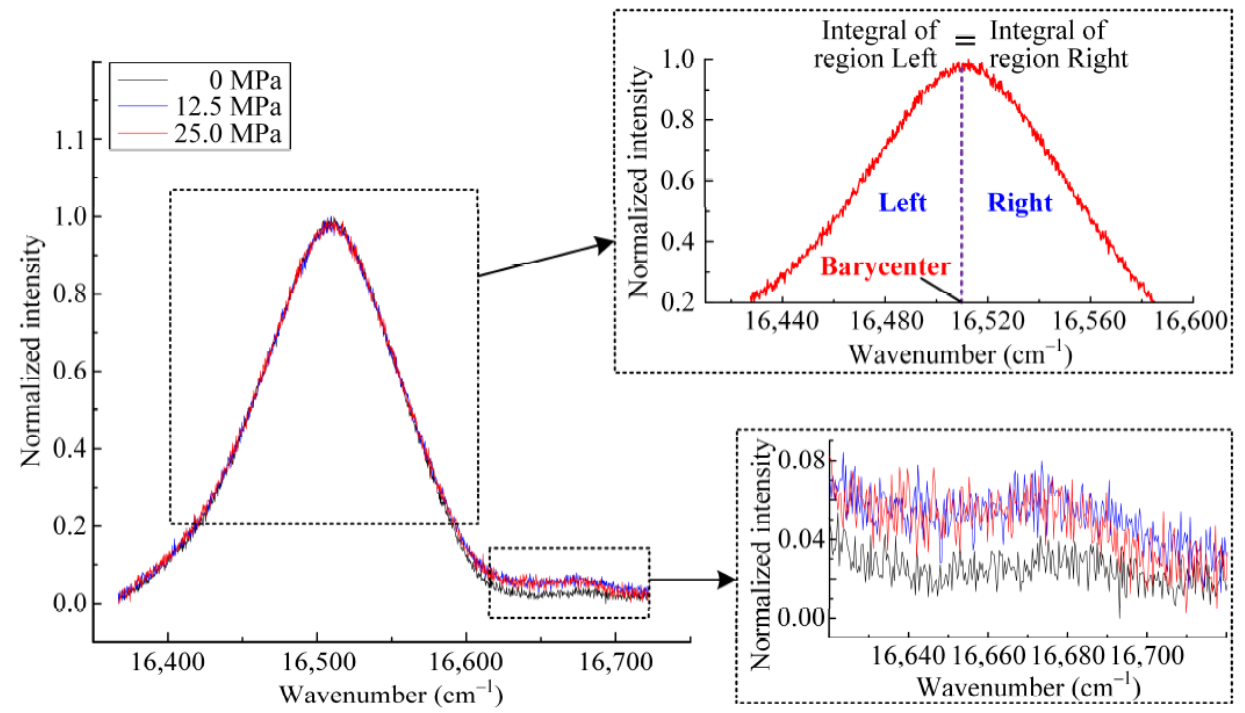
Figure 5. The intensity-normalized fluorescence spectra with the definition of barycenter in the upper right and the background noise in the lower right.